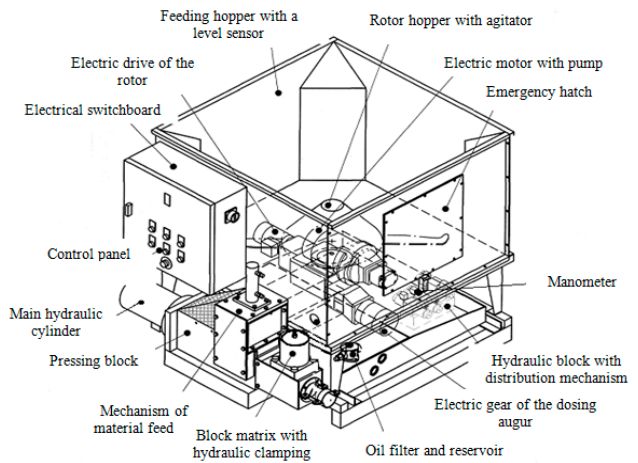
Figure 3. Diagram of hydraulic piston briquetting press BrikStar CS 50.